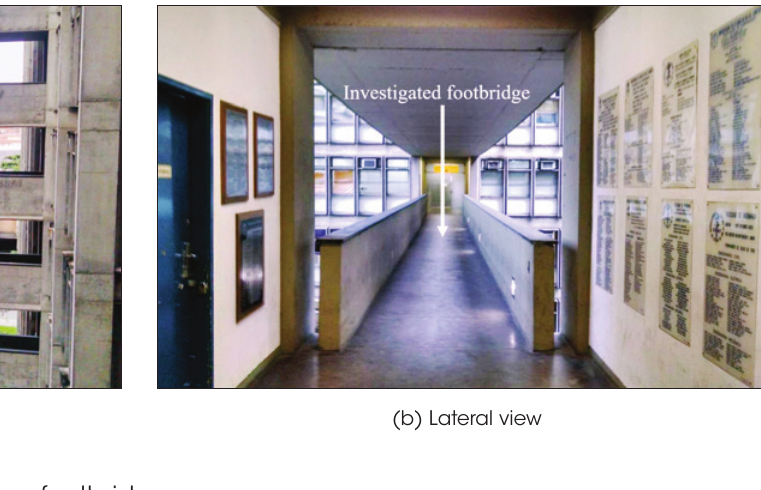
Investigated reinforced concrete pedestrian footbridge